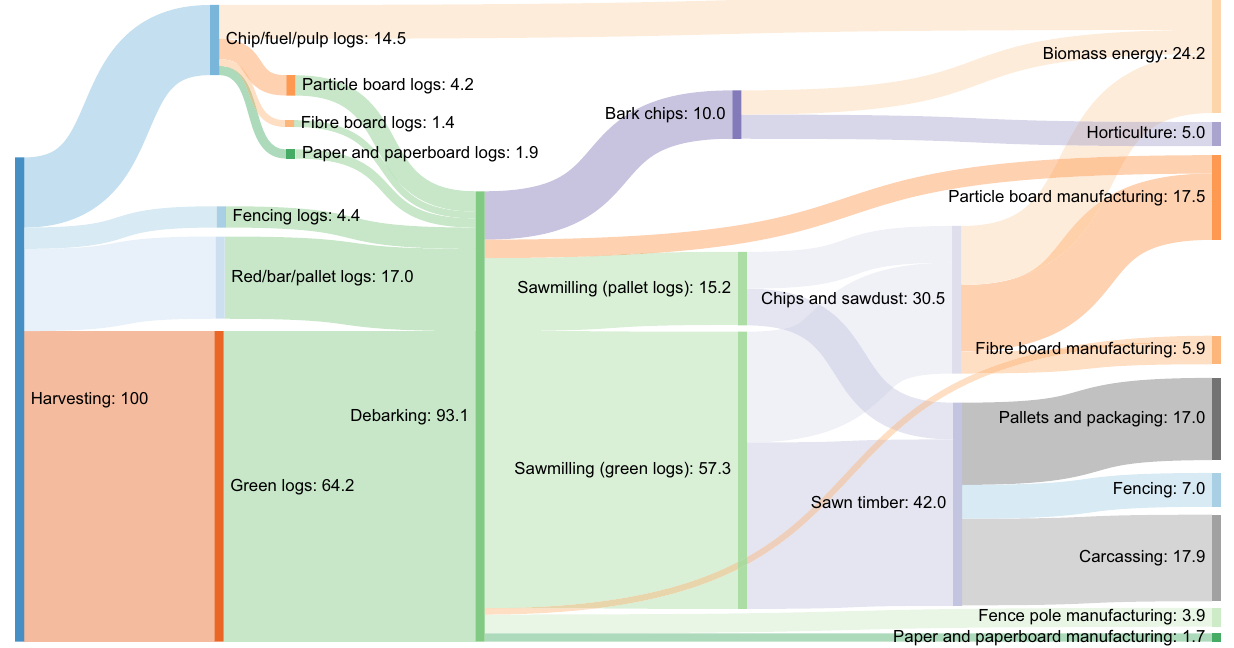
Fig. 3 Biogenic carbon material fl ow from wood harvest going to Hierarchical use. Units are percentages of original harvest calculated in the CBM model 54 . ‘ Red ’ and ‘ Green ’ refer to a quality threshold of acceptable straightness, taper and knots in a log accepted by sawmills, with ‘ Green ’ being the higher quality. Carcassing refers to construction grade sawn wood. Data sources include wood harvest volumes from the CBM-CFS3 model, sawmill product breakouts, UK statistics on wood waste and harvested wood product decay functions, elaborated in relevant sections of Methods and in S1.